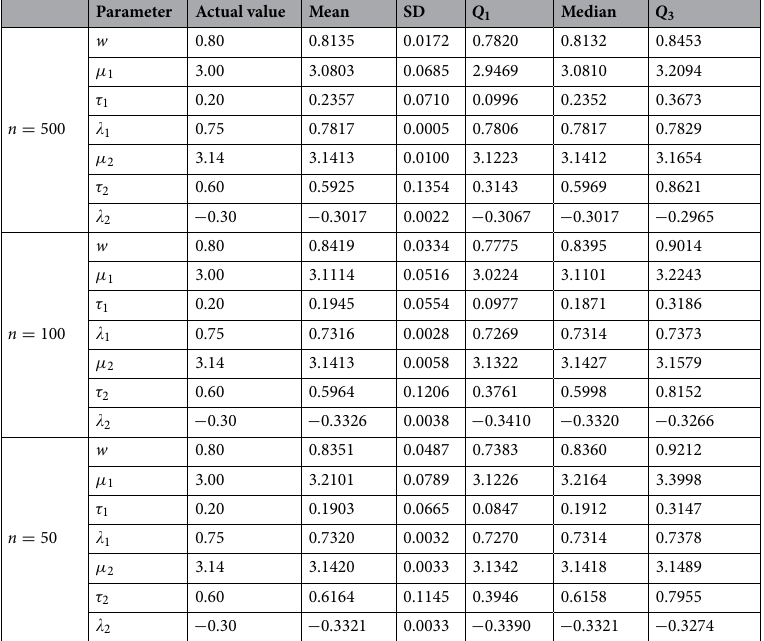
= 0 , τ 0 = 0.1 , α 2 = 6 , β 2 = 2 , ξ 2 = − 1 , σ 2 = 1.0 , c 2 = 1 2 2